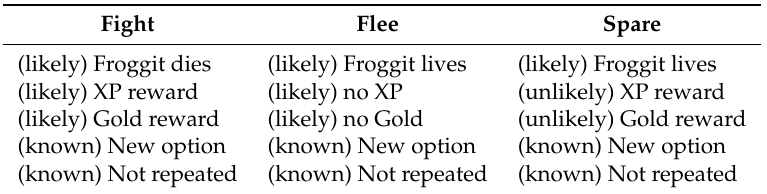
Table 1. Likelihood analysis for the player’s initial encounter with the choice shown in Figure